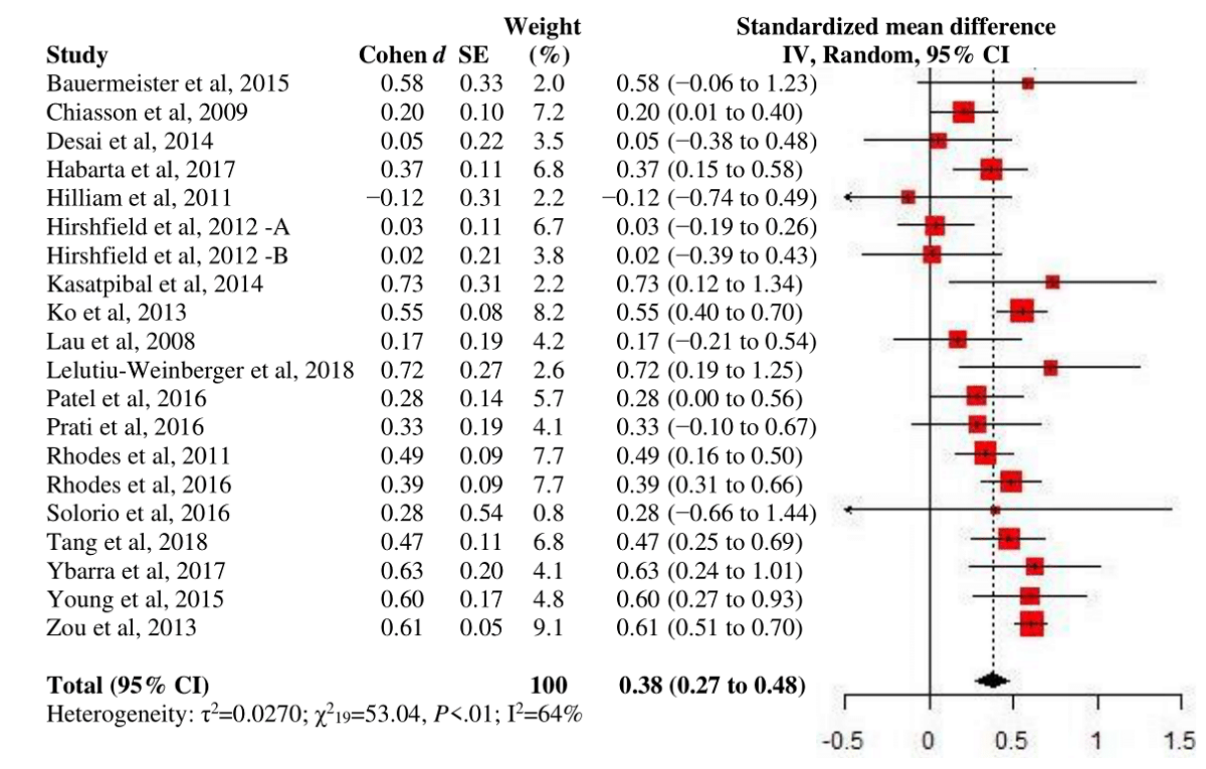
Figure 4. A forest plot of intervention effects on HIV testing.